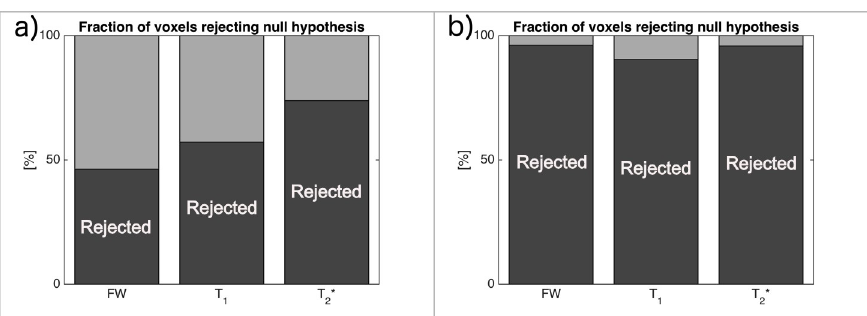
Fig 4. Fraction of voxels rejecting the null hypothesis (dark-grey) with a p-value of 0.05, hence supporting the statement that “the metric has decreased” for all voxels (a) and inside the ROI (b).